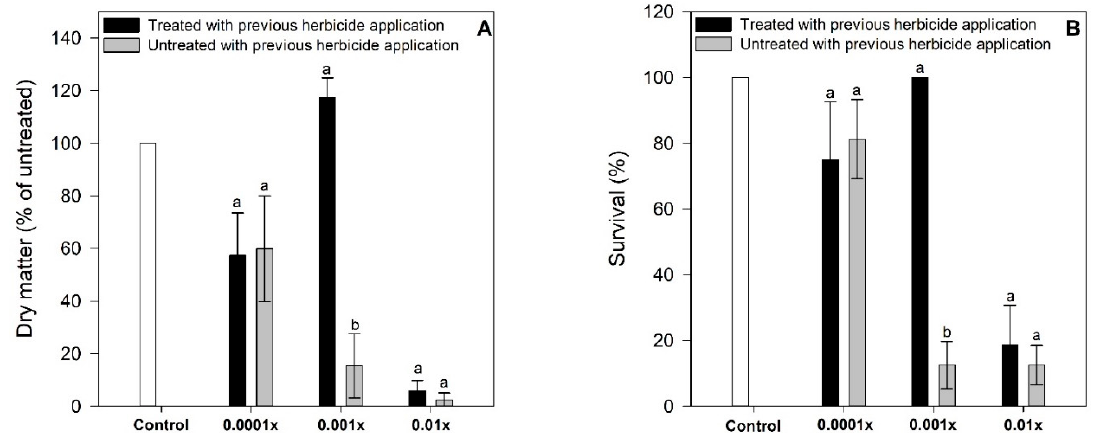
Figure 3. Dry matter accumulation ( A ) and survival ( B ) of susceptible Avena fatua L. plants that have been treated previously, and plants that received their first application of clodinafop propargyl at rates of 0.01, 0.001, 0.0001x of the recommended dose. Control plants only were sprayed with distillate water and adjuvant. Statistical significances are indicated with different letters. Datapoints represent mean values, and vertical bars represent standard errors. When they are absent, they are smaller than the symbol ( n = 4).